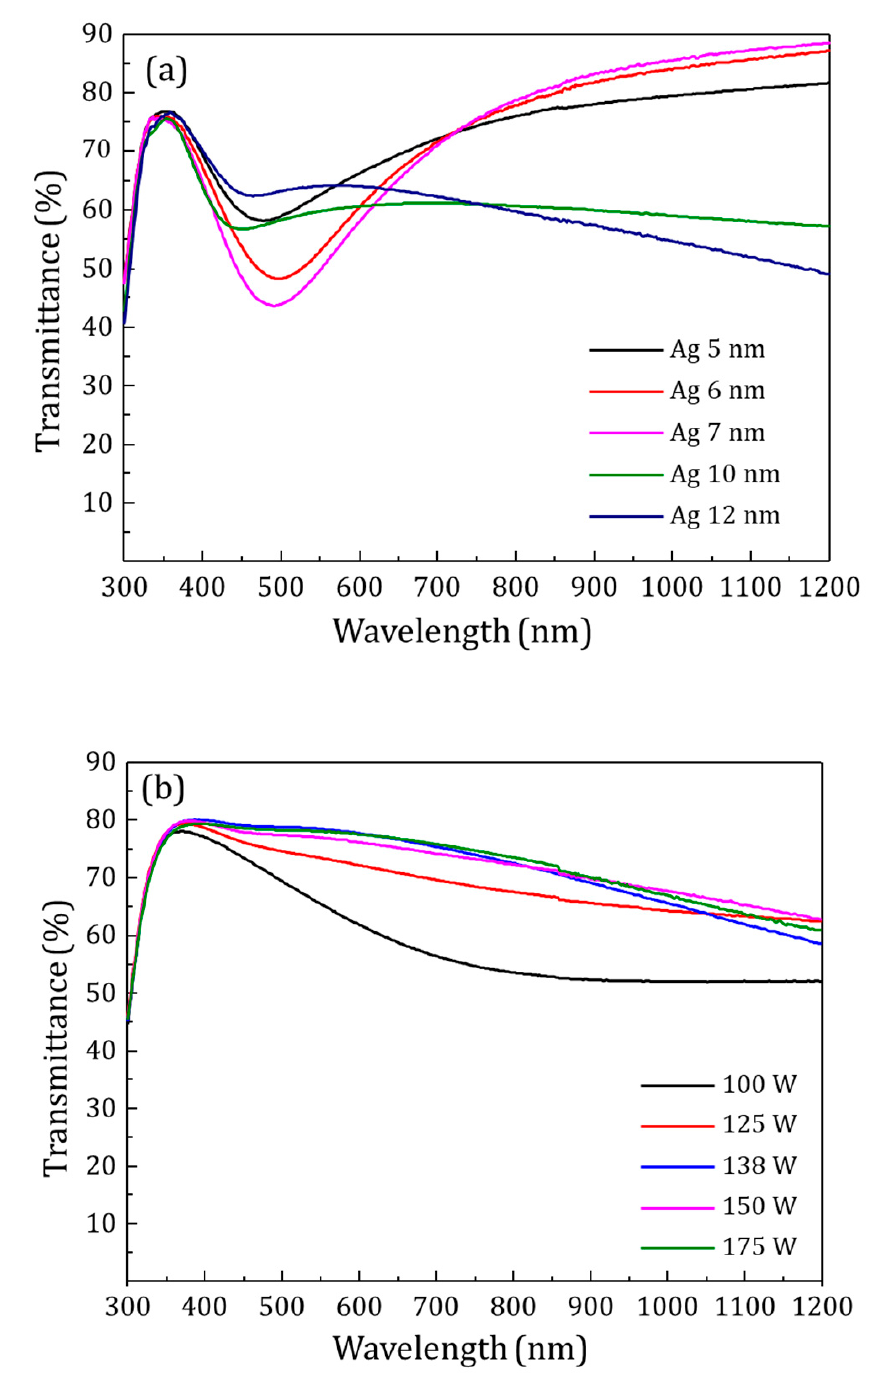
Figure 3. ( a ). Optical transmittance of Ag layers with varying thicknesses deposited on glass. The broad dip in transmittance were observed due to the discontinuity in the films. ( b ). Optical transmittance of Ag:Al films deposited on glass. Optimizing the doping of Al with di ff erent sputtering powers on Al target, fixing the Ag power at 100